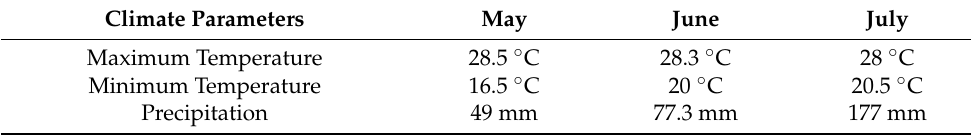
Table 1. Climatic data of the experimental site from May–July 2022. Climate Parameters May June July Maximum